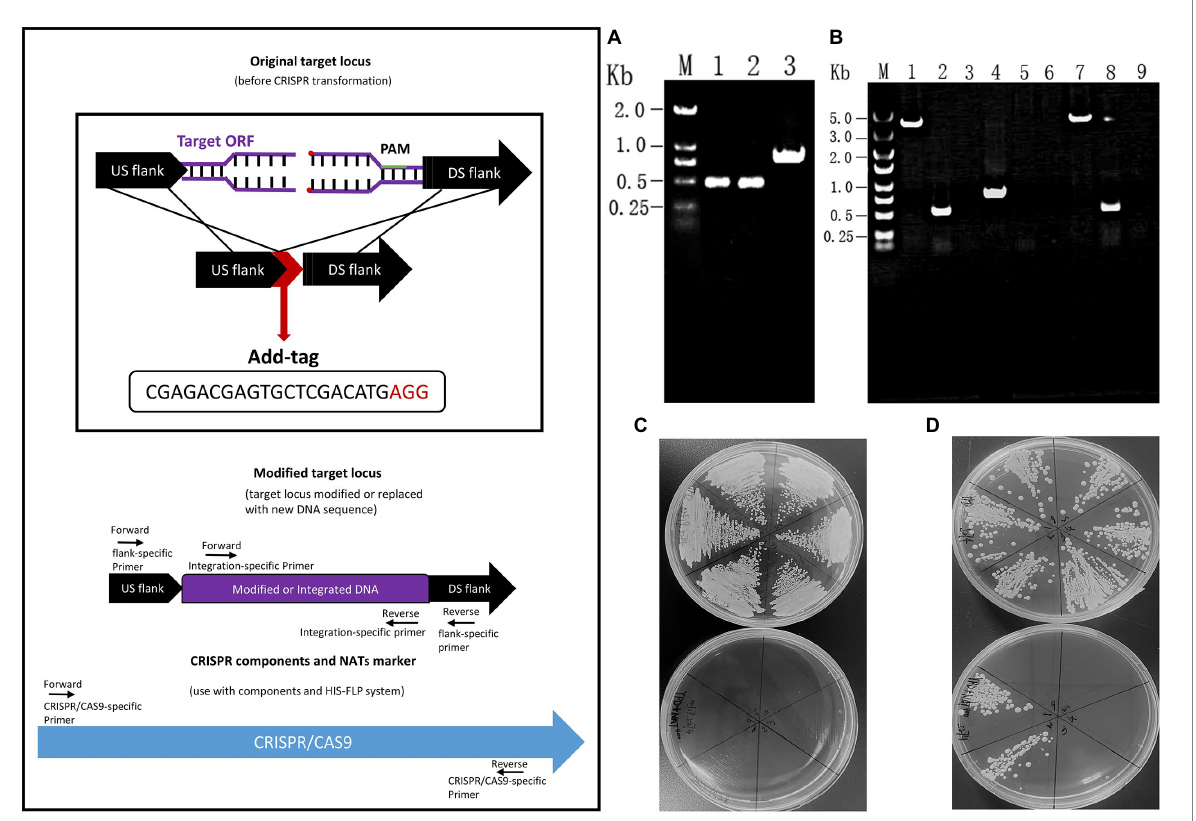
FIGURE 2 Construction and identification of orf19.5274 Δ / Δ and orf19.5274 Δ / Δ ::ORF19.5274 S trains. (A) Designing and identifying repair homology flanks. M: DL2000 Marker; 1–2: orf19.5274 _Up_F/R and Down_F/R amplification products; 3: orf19.5274 _Up_F/Down_R amplification products; (B) Colony PCR verification of SC5314, orf19.5274 Δ / Δ , orf19.5274 Δ / Δ ::ORF19.5274 . M: DL5000 Marker; 1–3: PCR products of SC5314 amplified by ORF19.5274 gene flanker, ORF, and CRISPR-specific primers, respectively; 4–6: PCR products of orf19.5274 Δ / Δ amplified by flanker, ORF, and CRISPR-specific primers, respectively; 7–9: PCR products of orf19.5274 Δ / Δ ::ORF19.5274 by flanking, ORF, and CRISPR specific primers, respectively; (C) Flip-out removal of CRISPR components and NATs marker in orf19.5274 Δ / Δ strain. Single colonies of orf19.5274 Δ / Δ were grow on YPD solid plates containing with or without NAT 400 for 2 days, the colonies that successfully removed the CRISPR component and NAT markers were able to grow on the YPD solid plates, but not on the YPD solid plates containing NAT 400 ; (D) Flip-out removal of CRISPR components and NATs marker in orf19.5274 Δ / Δ ::ORF19.5274 strain. Single colonies of orf19.5274 Δ / Δ ::ORF19.5274 were grow on YPD solid plates containing with or without NAT 400 for 2